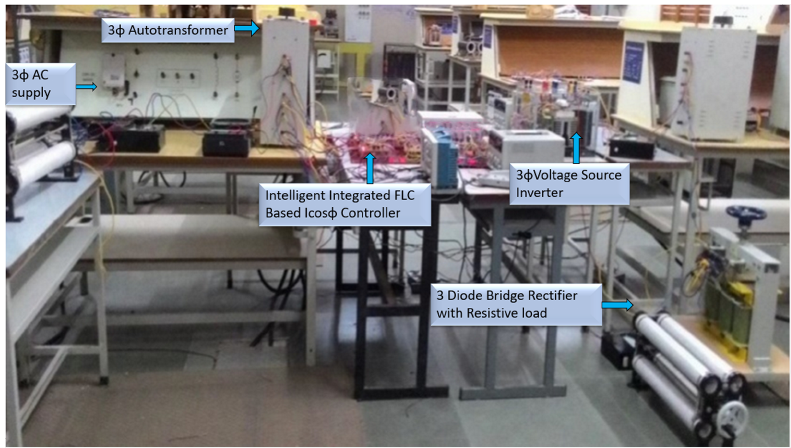
Figure 22. Laboratory prototype of proposed intelligent integrated FLC.